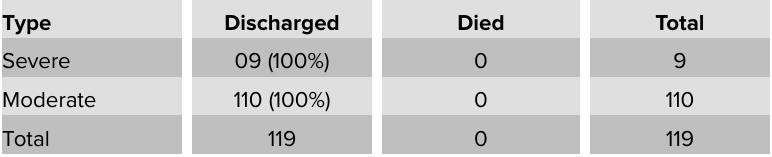
TABLE 2: Severity phenotype and outcome in the study group.